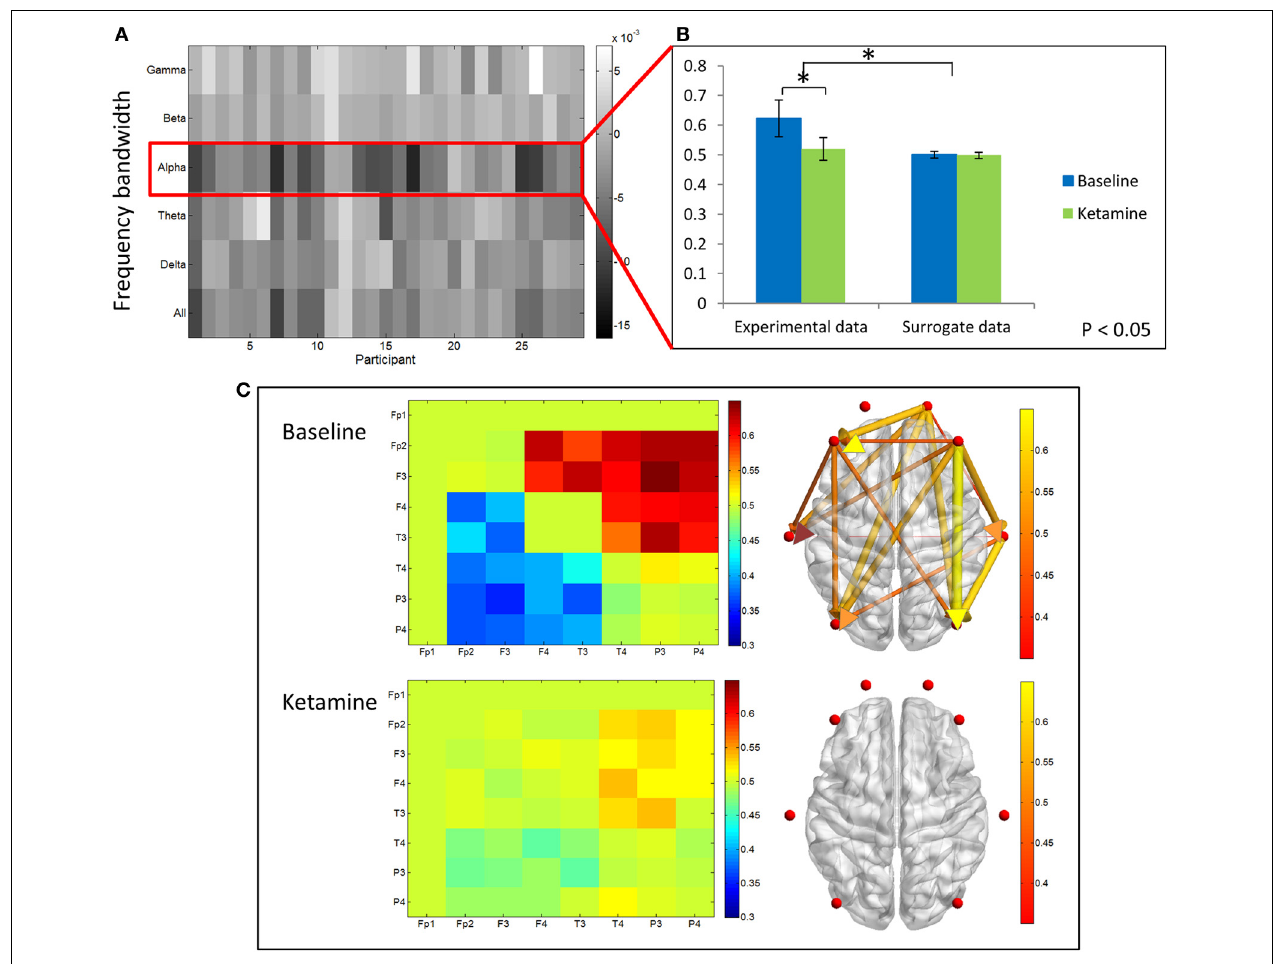
FIGURE 5 | Directed phase lag index analysis. (A) Difference in frontoparietal dPLI between baseline rest and ketamine-induced unconscious states, represented across six frequency bandwidths and all participants. The largest decreases in dPLI occur in the alpha bandwidth. Note that a dPLI value of 0.5 indicates neither phase lag nor phase lead relationship. (B) Average frontoparietal dPLI values for each state in experimental and surrogate data (error bars indicate standard deviation). Frontoparietal dPLI